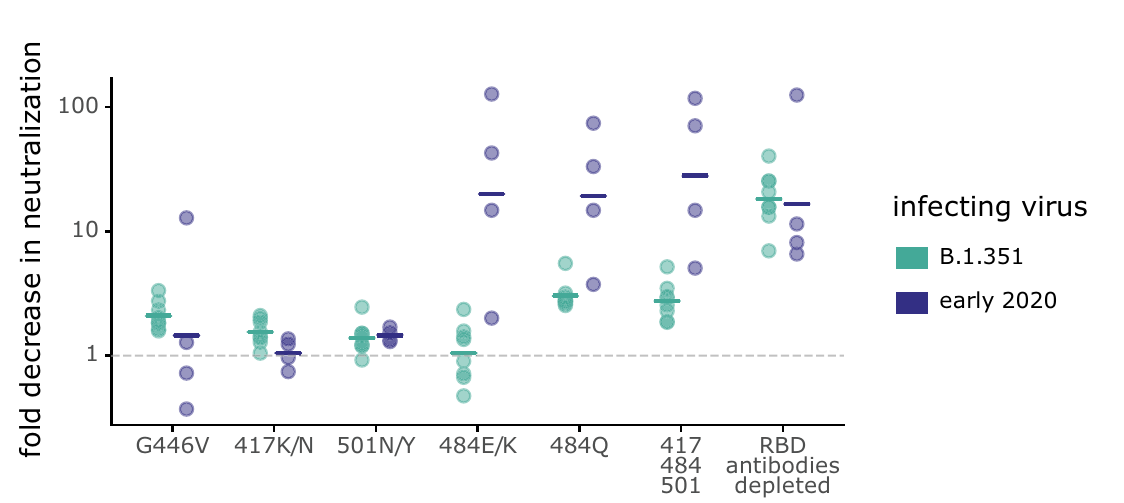
Fig 5. Some mutations have different effects on neutralization by B.1.351 and early 2020 plasmas. Plasmas from B.1.351- or early 2020-convalescent individuals were tested for neutralization of wildtype B.1.351 or D614G spike-pseudotyped lentiviral particles, respectively, and against the indicated point mutants in their respective parental backgrounds. The y-axis indicates the fold-change in neutralization caused by the mutations, with larger values indicating less neutralization. Each point is the average of two technical replicates for one individual. The crossbars indicate the group geometric mean. The dashed gray line is at 1 (i.e., mutation causes no change in neutralization). Sites 417, 484, and 501 differ between B.1.351 and early 2020 viruses, and so mutations are tested in each background that changes the identity to that in the other virus (e.g., E484K in early 2020 viruses, and K484E in B.1.351). Full neutralization curves and effects of mutations for each individual are shown in S5 Fig , and the numerical values and IC50s are given in S5 Data and at https://github.com/jbloomlab/SARS-CoV-2-RBD_B.1.351/blob/